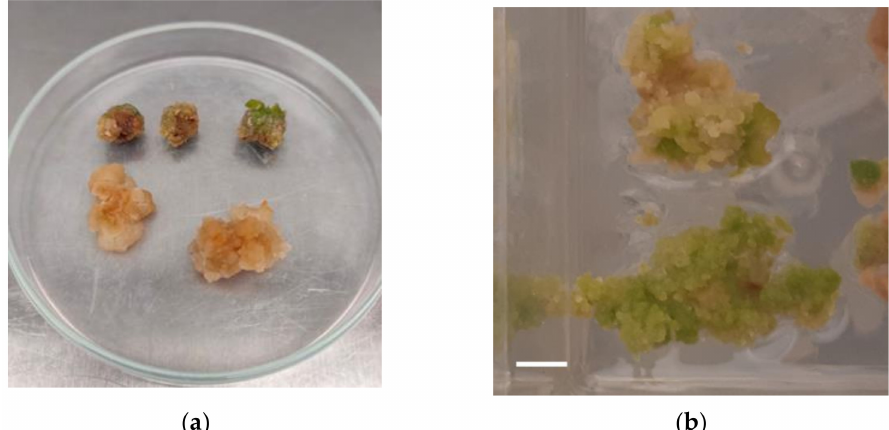
Figure 1. Callus induction: ( a ) Different appearance of calli depended on the callus induction medium. Petri dish diameter = 9 cm. ( b ) Callus induction in nodal segment explants of Cannabis sativa L. on MS medium containing 4.52 µ M 2,4-D after 3 weeks of culture. Bar = 1